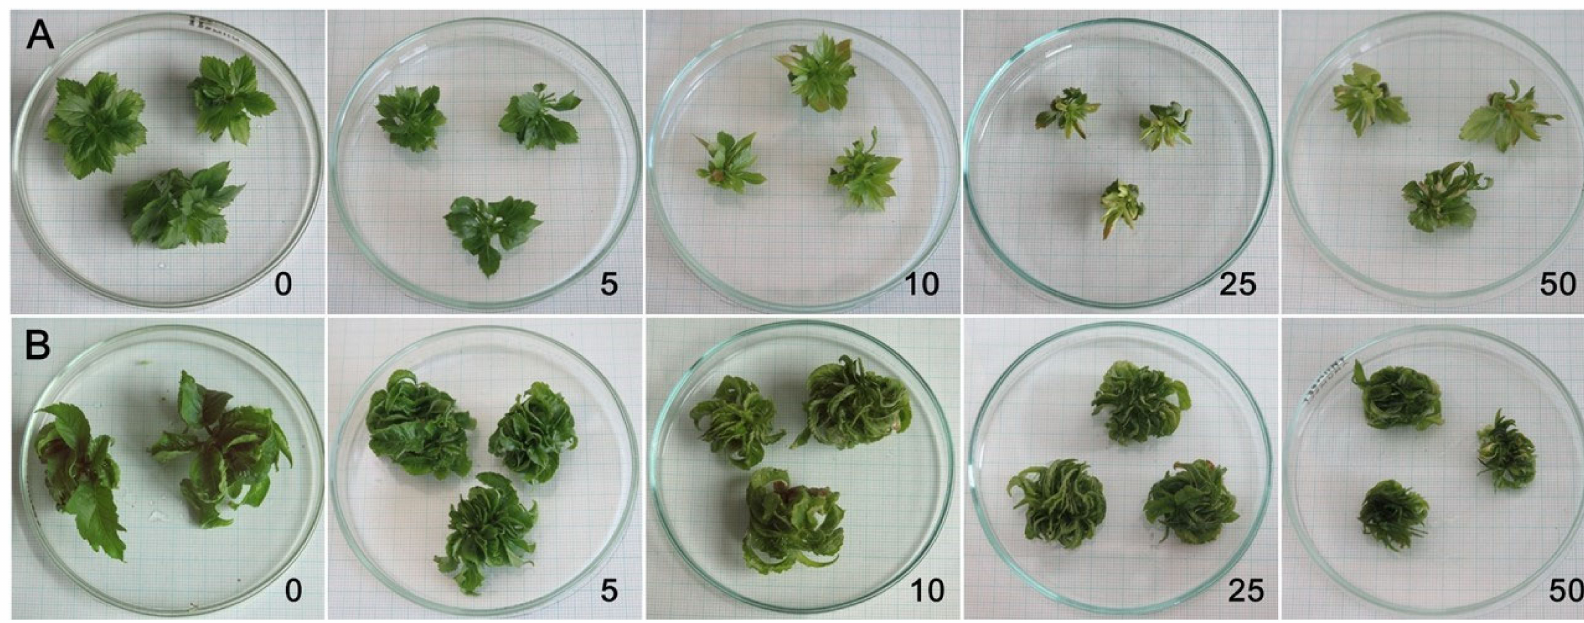
Figure 1. E ff ect of di ff erent concentration of polyethylene glycol (PEG-6000) on the growth and appearance of the in vitro culture of apple cultivar ”Idared” ( A ) and cherry cultivar “Sunburst” ( B ); Numbers indicate PEG concentration in g L − 1